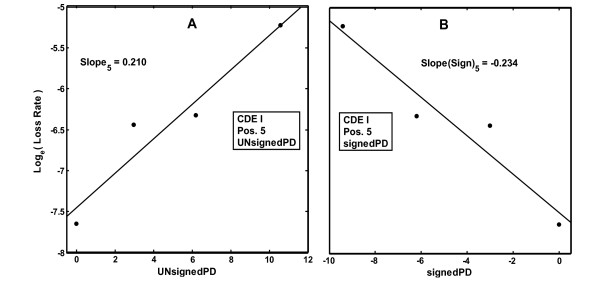
Position specific regression plots for CDEI position 5. Representative examples of two, position specific, 4 data-point linear correlations along with the regression slopes are presented. These are comprised of the 3 associated alternate base mutant data points along with the wild type data point for the CDEI position 5. This position possesses unusually good correlations for both unsignedPD (A) and signedPD (B) plots.